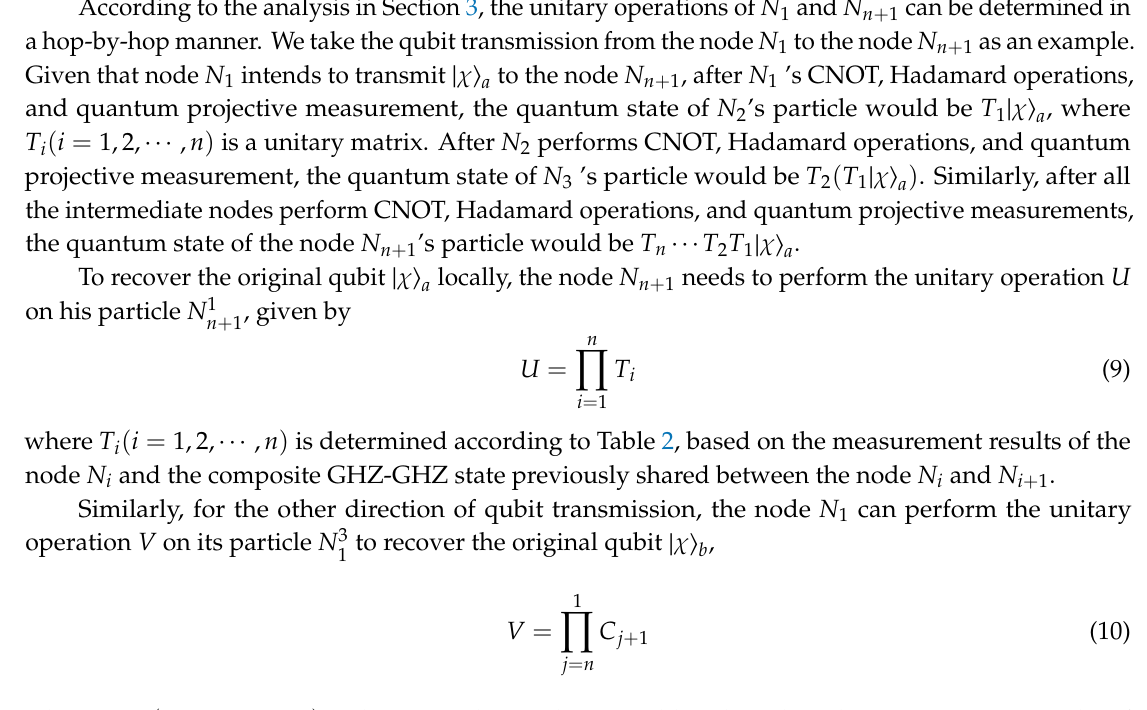
Figure 5. The composite GHZ-GHZ entanglement channel in the n -hop quantum communication case.